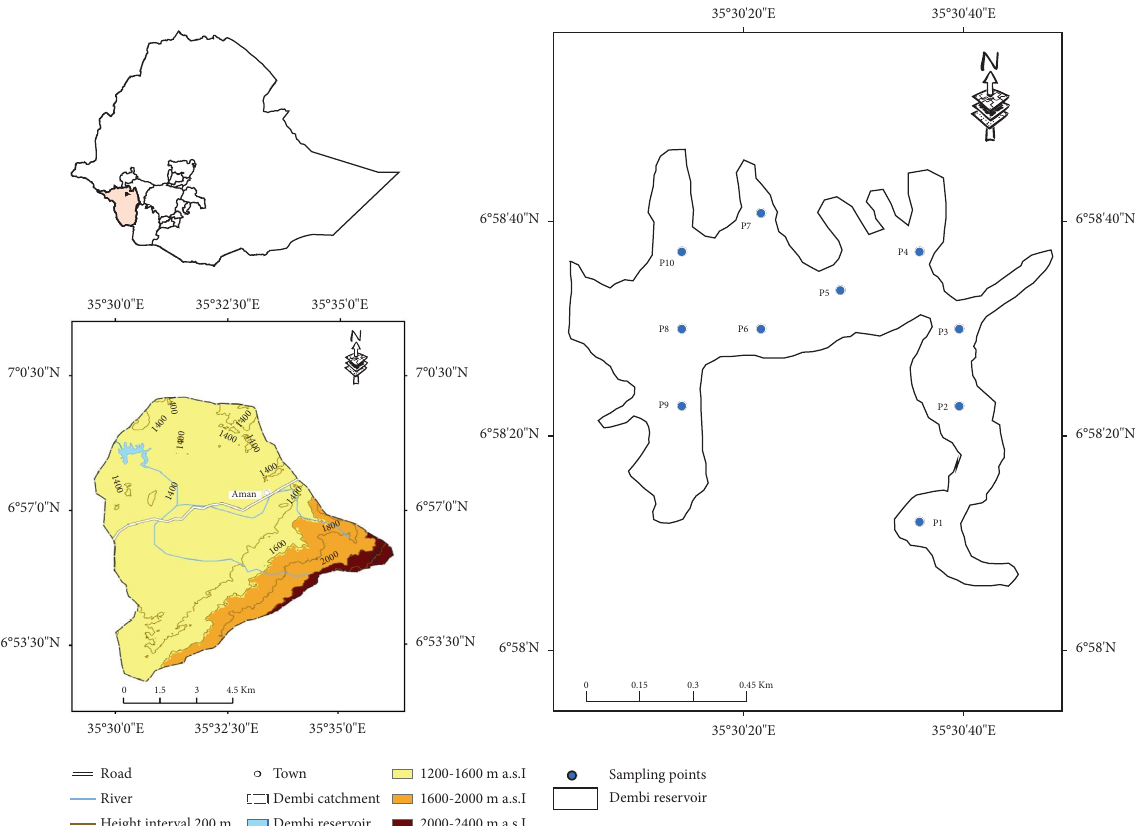
Figure 1: Location of the study